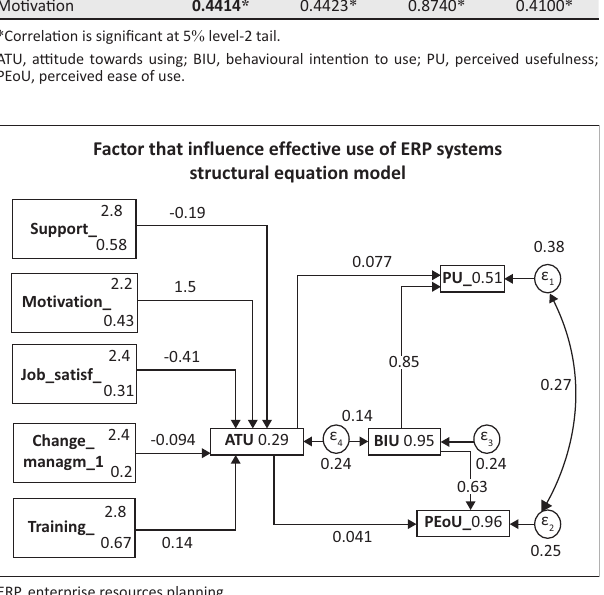
FIGURE 3: Adapted technology acceptance model and path analysis of